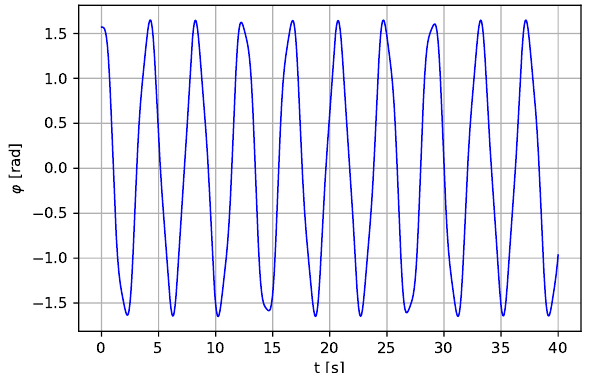
Figure 1. Angular displacement of the Pendulum in Equation (1).